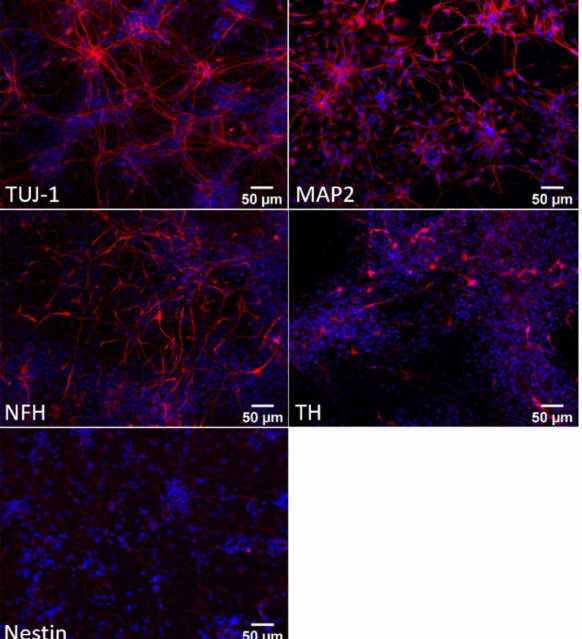
Figure 5. Characterisation of iPSCs differentiated for 60 days into dopaminergic neurons. Repre- sentative immunofluorescence images of human iPSC-derived dopaminergic neurons at day 60 of differentiation. Cells were stained (red) for the neuronal markers β -III-tubulin (TUJ1), neurofilament H (NF-H), microtubule-associated protein 2 (MAP2) and tyrosine hydroxylase (TH), and for the neu- ronal precursor marker nestin. Cell nuclei were stained with Hoechst (blue). Images were acquired at 200 ×